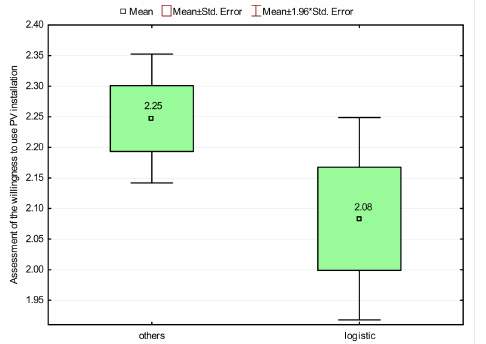
Figure 10. Which sectors of the economy are most affected by decarbonization policies (logistics) vs. assessment of the willingness to use PV